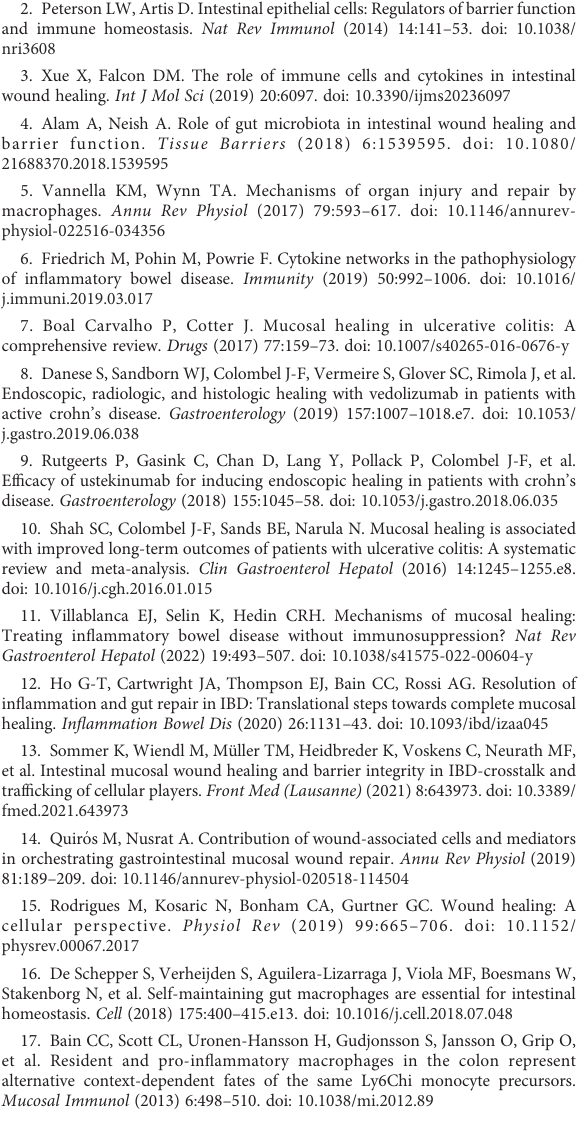
SUPPLEMENTARY FIGURE 2 (A) Representative gating strategy for the identi fi cation of splenic macrophages. Linage markers included Cd49b, Cd3, Cd19 and Ly6G. (B) Representative gating strategy for the identi fi cation of gut macrophages. SUPPLEMENTARY FIGURE 3 (A) Representative (left) and quantitative fl ow cytometry (right) of the expression of Cd64 + Cd11c int cells in LPMCs of Nr4a1 -/- (n=9) and WT (n=9) mice. (B) Quantitative immuno fl uorescence for the perilesional expression of Cd68 and F4/80 for the Arg1 staining in intestinal wound areas of Nr4a1 -/- mice (n=9) and WT mice (n=9) on day 5 after